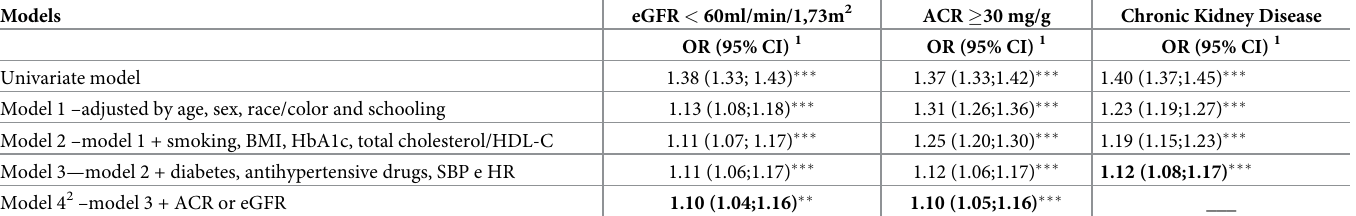
Table 2. Logistic regression models of the association between pulse wave velocity (m/s) and renal function markers in adults without CVD, participants in the ELSA-Brasil cohort baseline, 2008–2010. Models